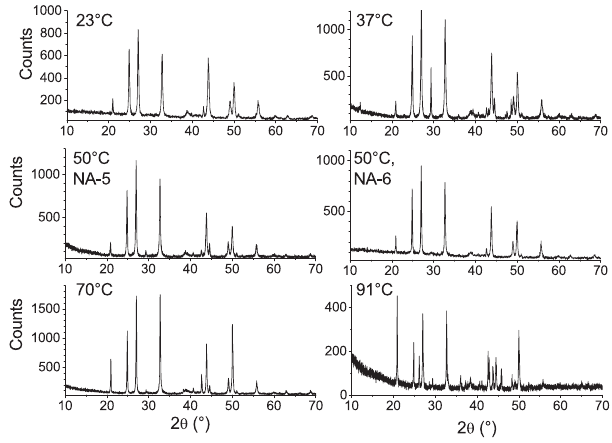
Figure 6. High-resolution SEM images of vaterite aggregates show- ing the internal structure in the order of increasing precipitation temperatures ( a , 23; b , 50; c and d , 91 ◦ C). Two different growth structures are observed at 91 ◦ C: aggregation of µm-sized flat crys- tallites (c) and tree-like branching growth resulting in flat platelets (d) .